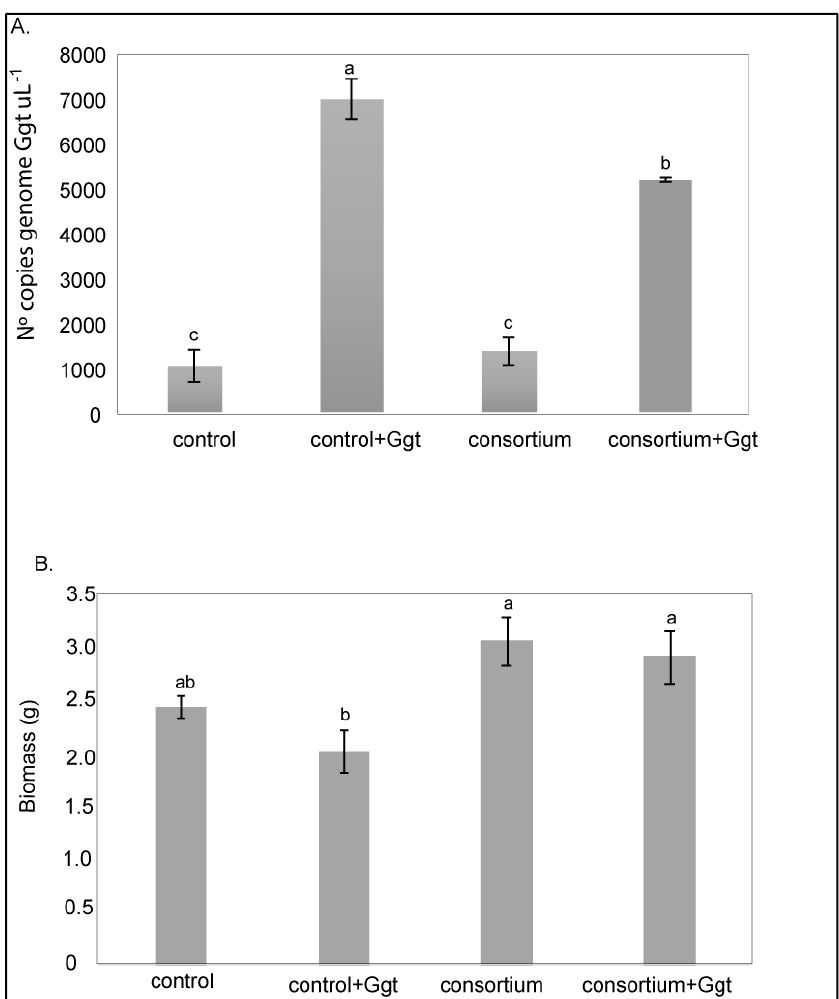
Figure 4. ( A ) Detection and quantification of the number of Ggt genome copies in infected roots 90 days after inoculation with Ggt; and ( B ) root biomass (g). Tukey’s test was used to compare treatment means; values followed by the same letter did not differ at p < 0.05 ( n = 5). With respect to lipid peroxidation, a similar tendency to that found in greenhouse conditions was observed. Therefore, control plants inoculated with Ggt and without bacterial strains displayed significantly more TBARS content than plants inoculated with the bacterial consortium (Figure 5). In contrast, TBARS production in plants inoculated with consortium was similar to plants without infection (control). Similarly, SOD activity was significantly higher in plants infected with Ggt, evidencing the oxidative stress due to disease incidence (Figure 5A). However, when plants were inoculated with the bacterial consortium, the SOD activity was significantly decreased ( p < 0.05), reaching levels similar to those of noninfected plants (Figure 5B).